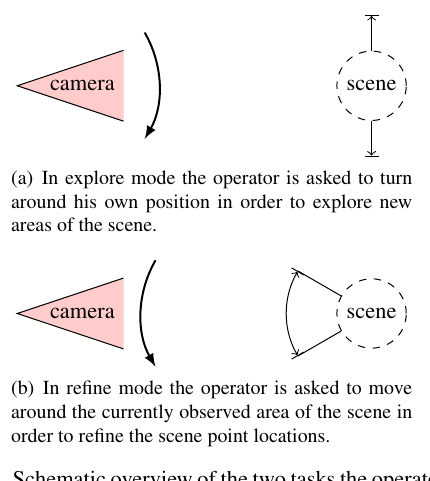
Figure 2: Schematic overview of the two tasks the operator needs to fulfill by turns. The camera (left) needs to move differently round the objects